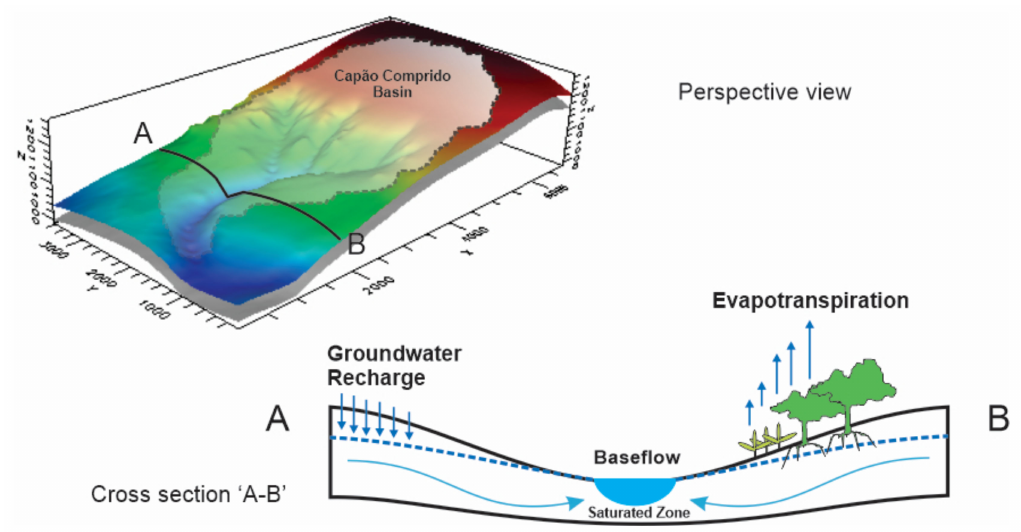
Figure 3. Conceptual model of the groundwater recharge and flow in the numerical model.perspective and cross section